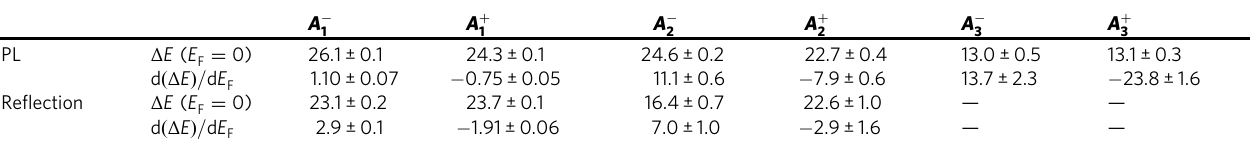
Δ E ( E ¼ 0) denotes the energy separation (in the unit of meV) between the exciton and exciton polaron at the charge neutrality point. d ð Δ E Þ = d E F energy ( E F